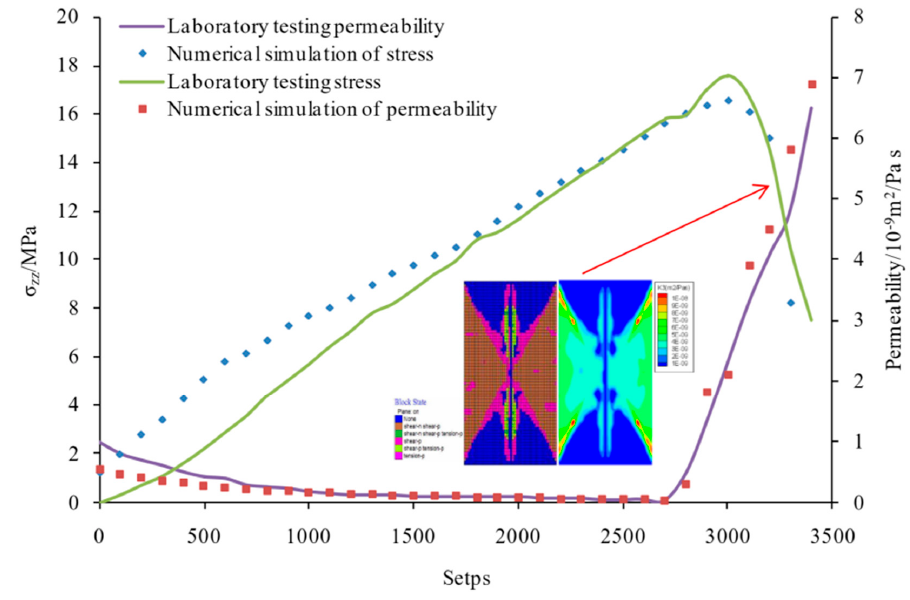
Figure 2. Modelling results of uniaxial compression and permeability-stress change curve [34].